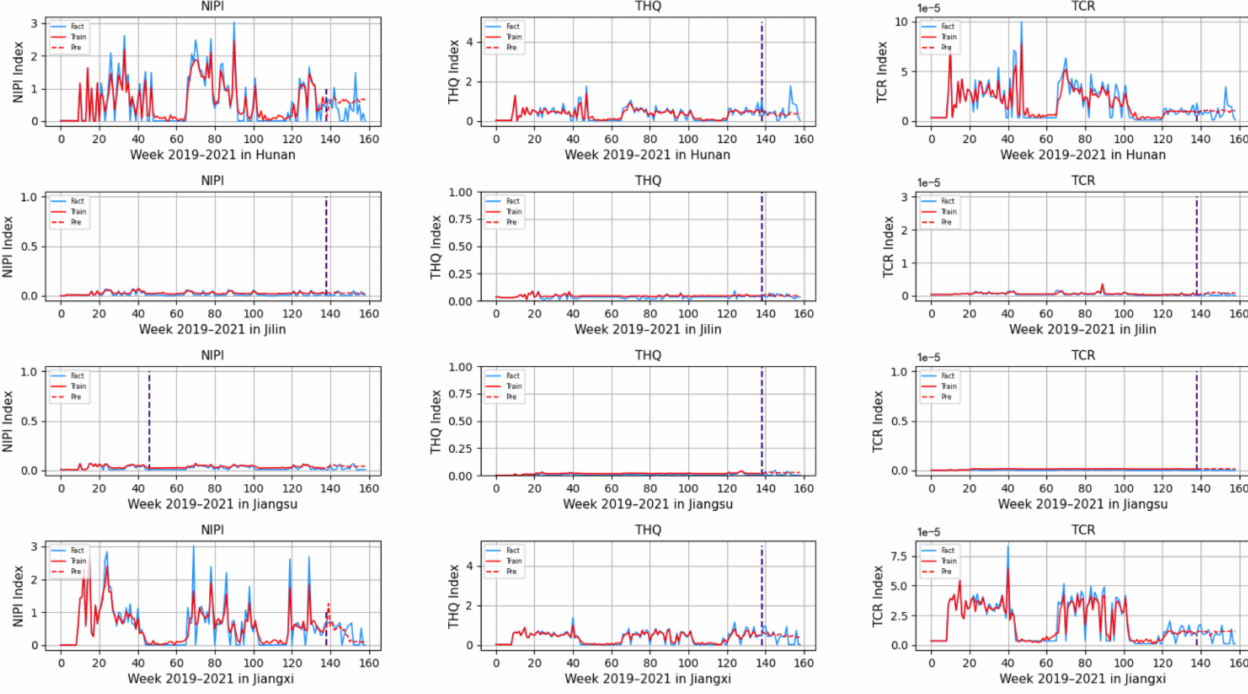
Figure 13. Predicted NIPI, THQ, and TCR indicators for Hunan, Jilin, Jiangsu, and